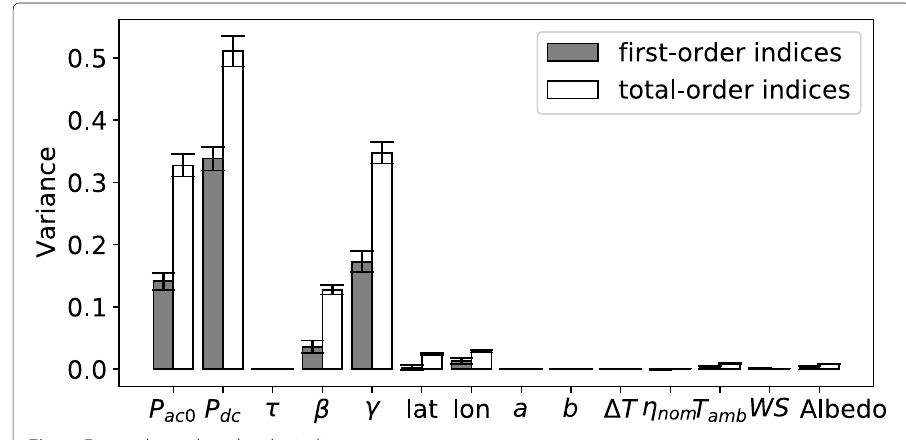
Fig. 1 First-order and total-order